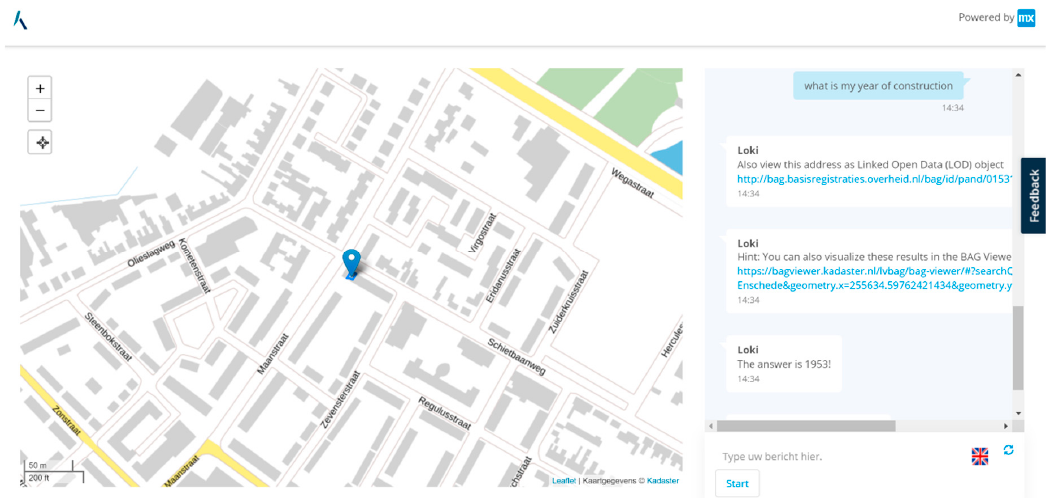
Figure 8. Interface of Loki consisting of a chat pane (on the right) and a map view pane (on the left; source: authors).